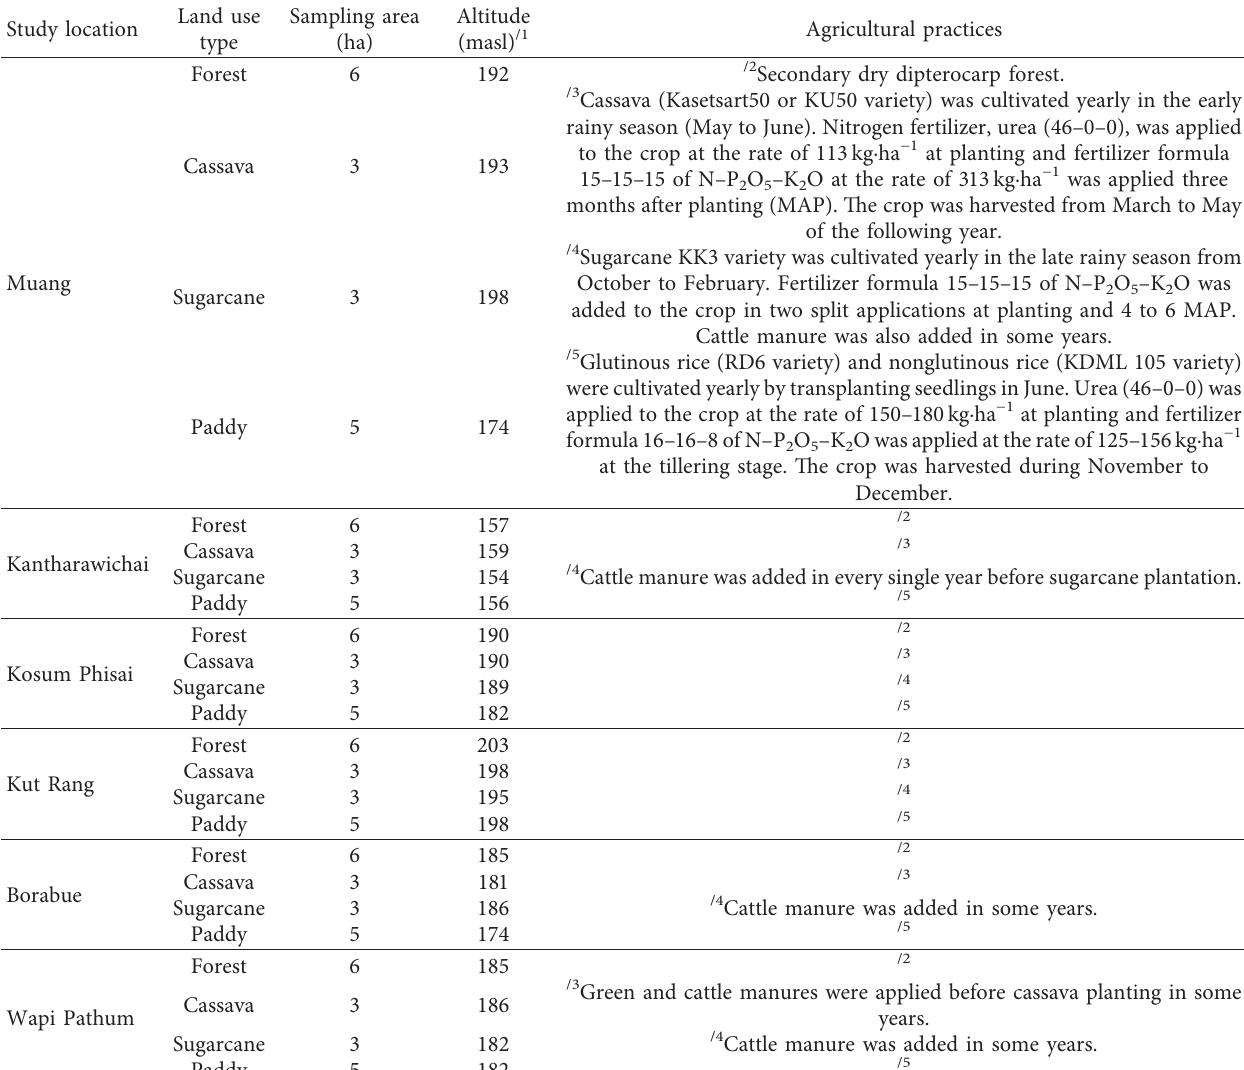
Table 1: Characteristics and agronomic management of studied plots of different land use systems at various